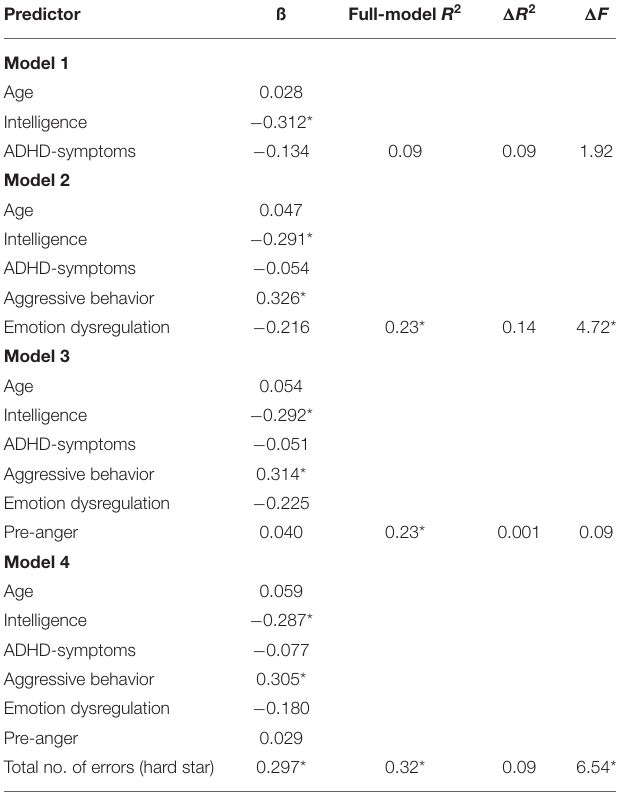
FIGURE 1 | (A) Negative emotion intensity ratings before and after frustration from 0 to 150 of women with borderline personality disorder (BPD) and healthy controls (CON). See text for significances. (B) Frustration-induced changes in negative emotion intensity of women with BPD and healthy controls. Women with BPD showed significantly higher increase in anger (** p Bonferroni < 0.001). Bars reflect group means and error bars indicate one standard error of the mean.